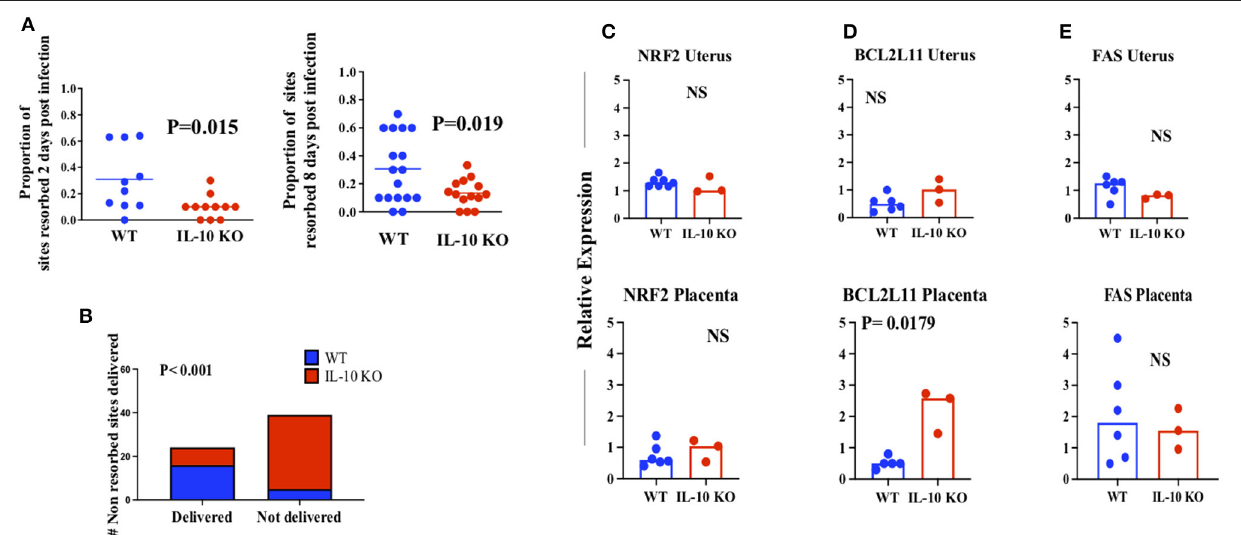
FIGURE 2 | Effect of LCMV infection on pregnancy outcome in WT and IL-10 KO mice. (A) Proportion of implantation sites resorbed (necrotic) 2 days (left, n = 10 WT and 11 IL-10 KO mothers euthanized) and 8 days (right, n = 17 WT and 14 IL-10 KO) post infection. Each symbol represents a mother euthanized. (B) Number of non-resorbed sites delivered. Uteri ( n = 5 WT and 7 IL-10 KO) were opened on day 19 of gestation and the presence of a pup was counted as a “non-delivered” site. Lines, sample means. p values, analysis of significance by the t test. (C–E) RNA expression by QT-PCR of the indicated molecules in the indicated tissues on day ∼ 18 of gestation. Bars, sample medians. p values, analysis of significance by the Mann Whitney test. Blue symbols, WT; Red symbols IL-10 KO. NS, not significant at the p < 0.05 level.